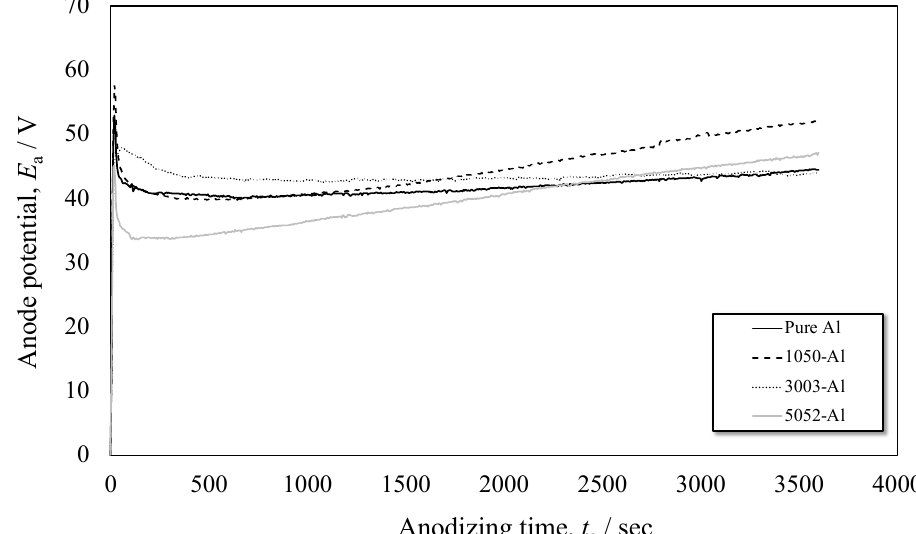
Figure 3. Anode potential transients ( E a vs. t a ) during anodizing of pure Al, 1050-, 3003- and 5052-Al alloys with a constant c.d. of 200 Am − 2 in 2 wt% -(COOH) 2 solution at 313 K. Figure 4 shows SEM images of surfaces of (a) pure Al, (b) 1050-al alloy, (c) 3003-Al alloy, and (d) 5052-Al alloy specimens, after anodizing for t a = 1800 s. The surface of anodic oxide films after anodizing for t a = 1800 s is smooth on pure Al and has many pits on the Al alloys. Comparing Figure 4 with Figure 2, one can see that surface morphology is quite consistent on each specimen with t a = 1800 s and with t a = 0.